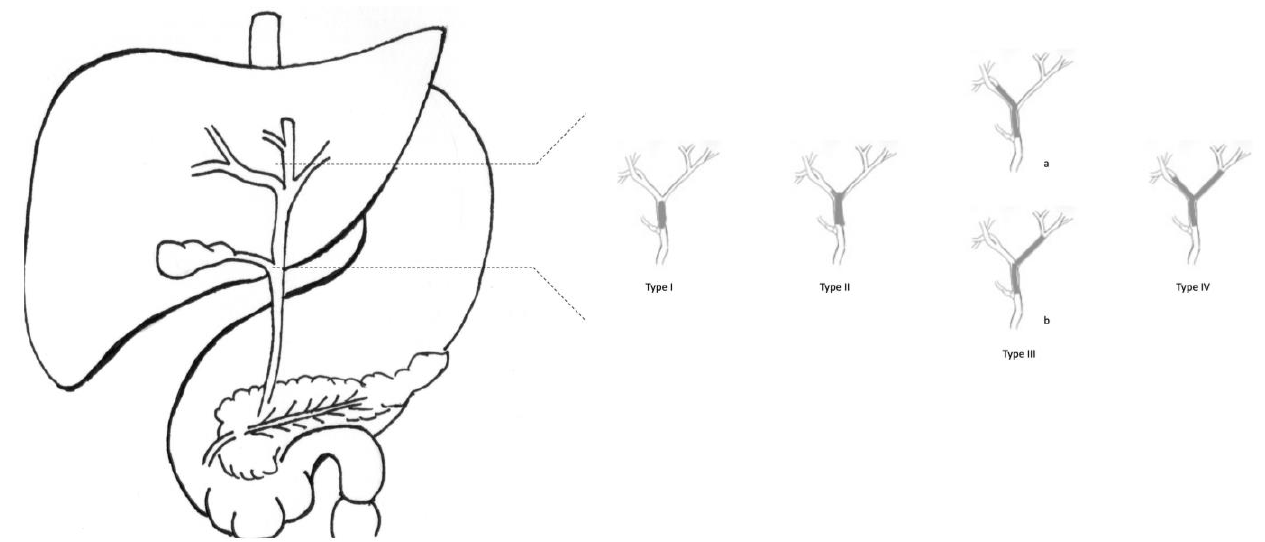
Figure 1. Graphic representation of the Bismuth – Corlette classification.